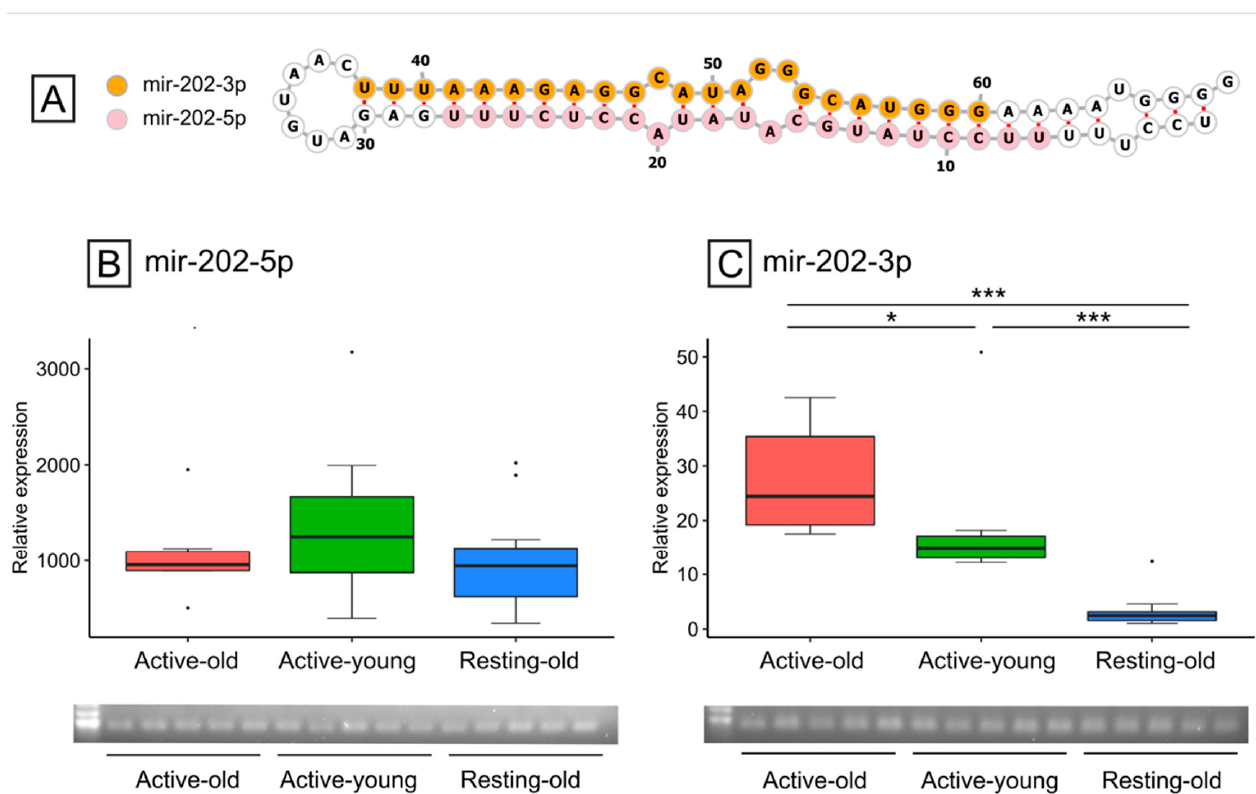
Figure 4. Precursor sequence and expression of mir-202 in the three groups identified. ( A ) Putative hairpin with 5p and 3p arms. ( B , C ) Expression of mir-202 in the three groups with the relative 2% agarose gels to further confirm the specificity of the amplification. Statistical significance: *** p < 0.001, * p < 0.05.